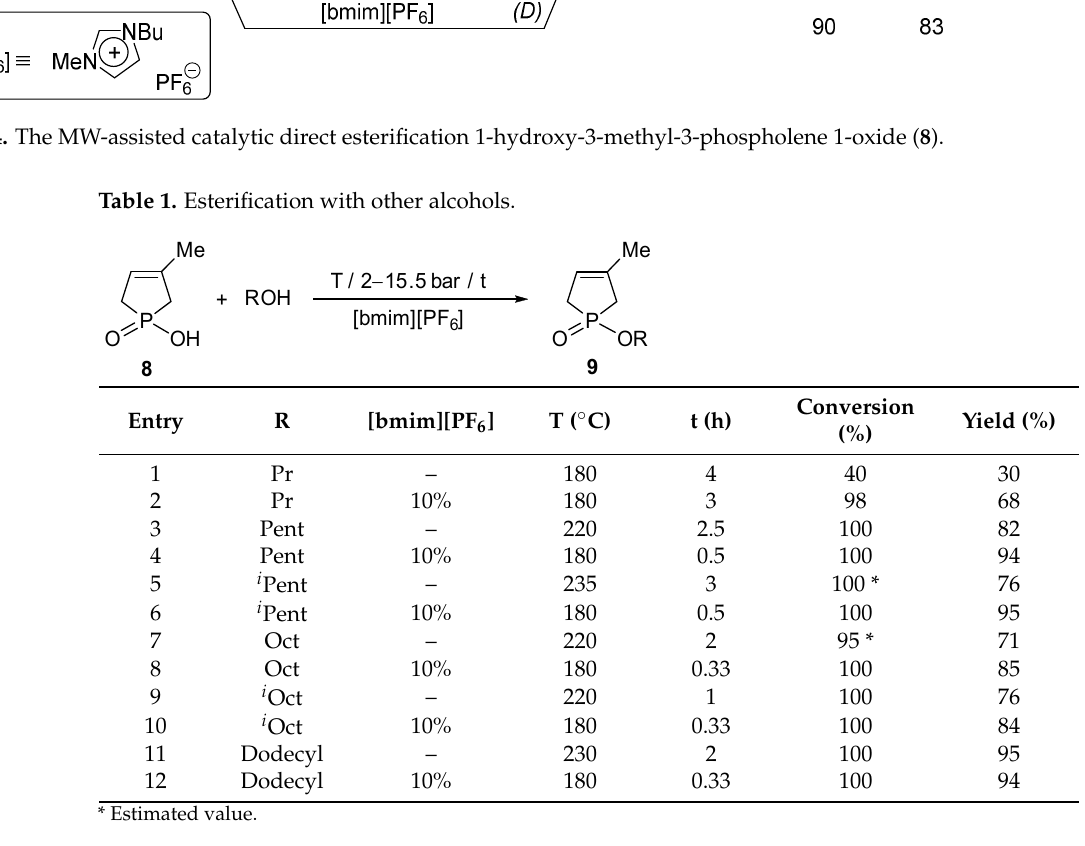
Table 2. Extension of the MW ‐ assisted IL ‐ catalyzed direct esterification to other cyclic phosphinic